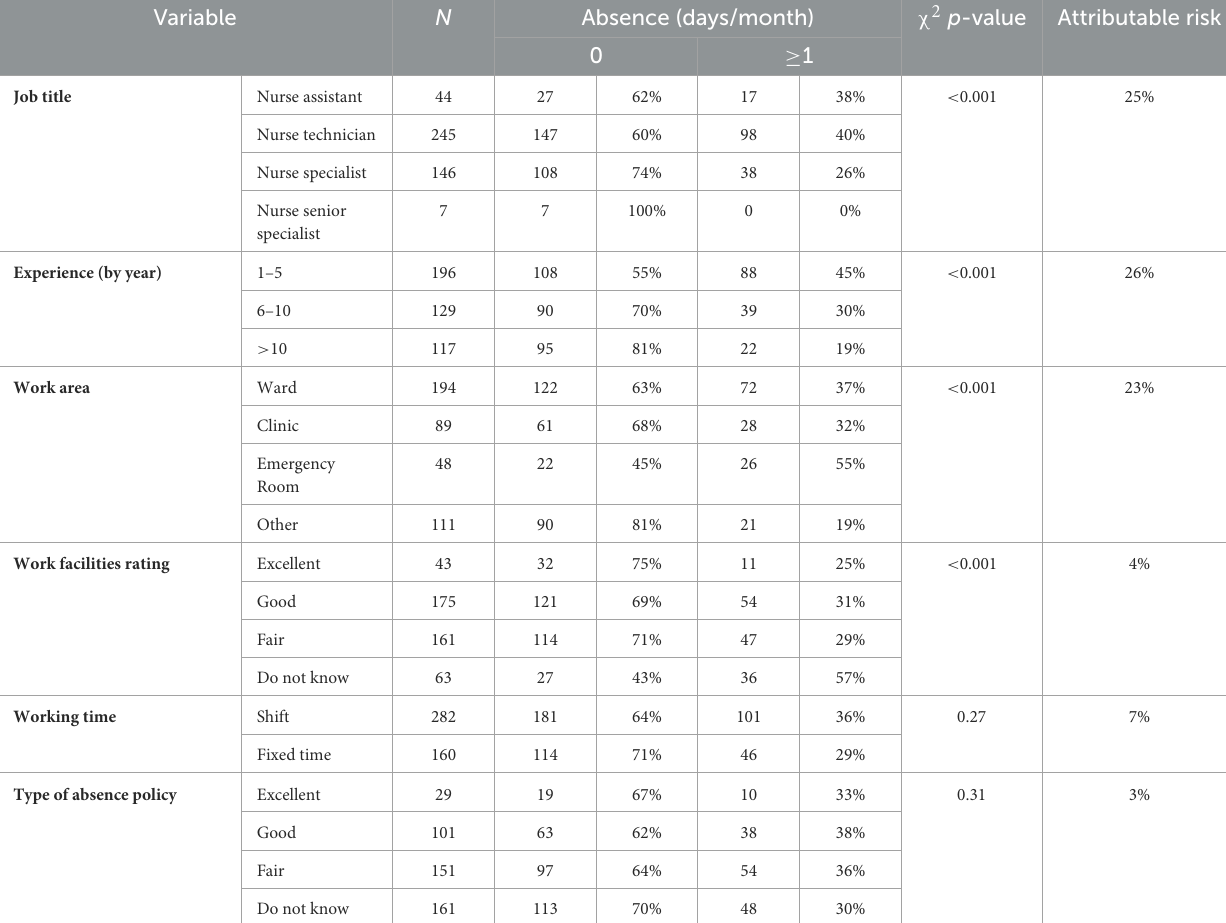
TABLE 2 Work factors associated with